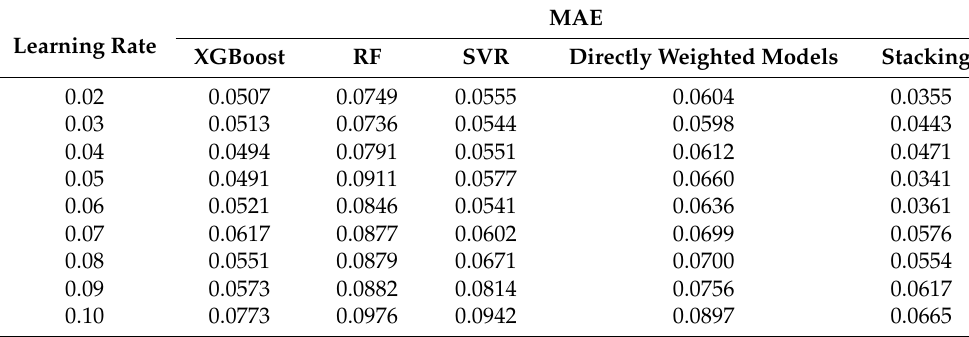
Table 5. Average absolute error of each model under different learning